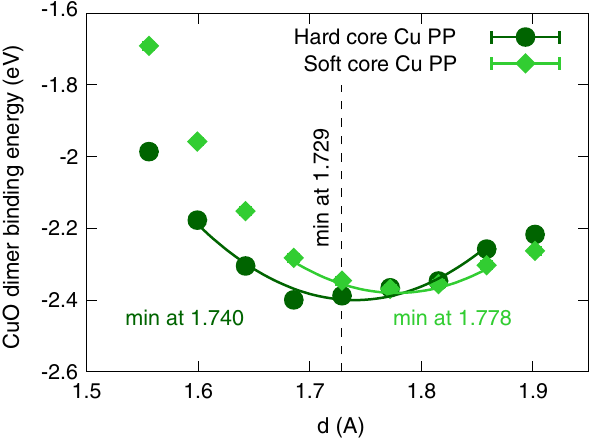
FIG. 4. Binding energy as a function of the interatomic separation d in a CuO dimer molecule. The vertical dashed line indicates the experimental equilibrium separation. The solid lines are a quadratic fit to the